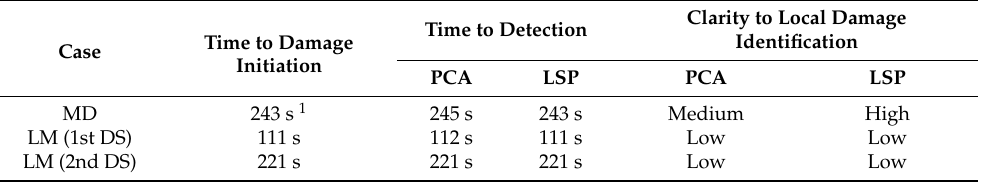
Figure 19. Results of damage detection for the case of the limited measuring points. The WPES-based ( a ) PCA and ( b ) LSP methods are demonstrated, respectively. Table 2. Performance of damage detection with missing data (MD) and limited measurement (LM) cases using the WPES-based PCA and LSP